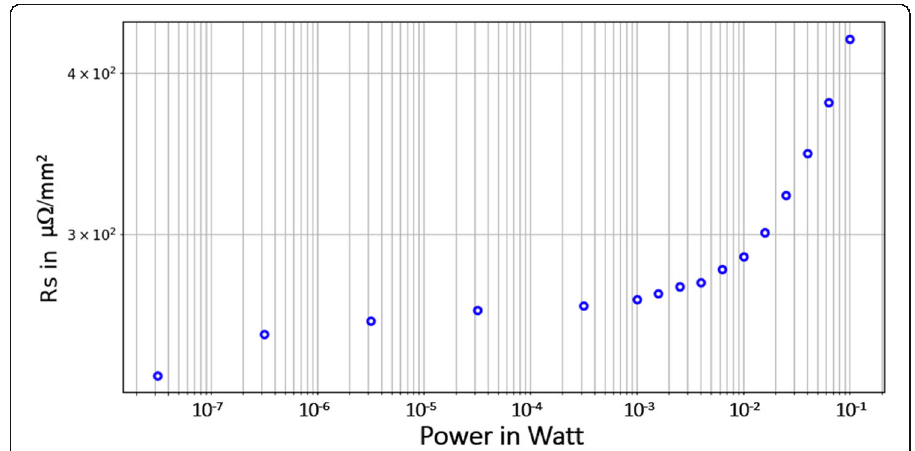
Fig. 7 Coil surface resistance was measured from the average of ρ comp values (see red circles shown in Fig. 6) as function of the different incident power